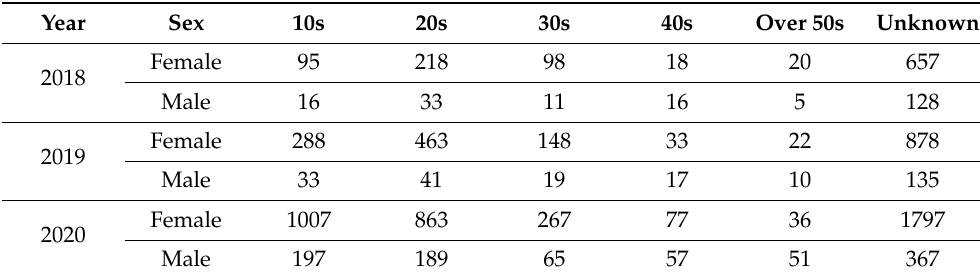
Table 1. Age Group of Victims by Year [18].